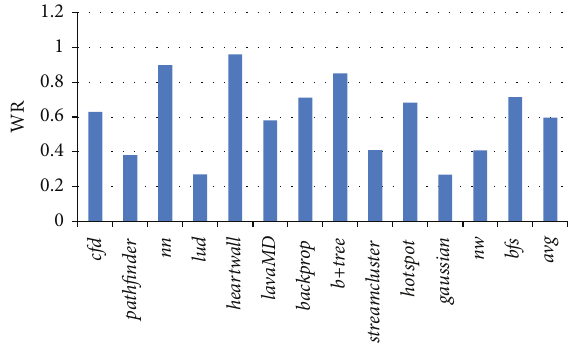
Figure 3: Memory request queue length on shared